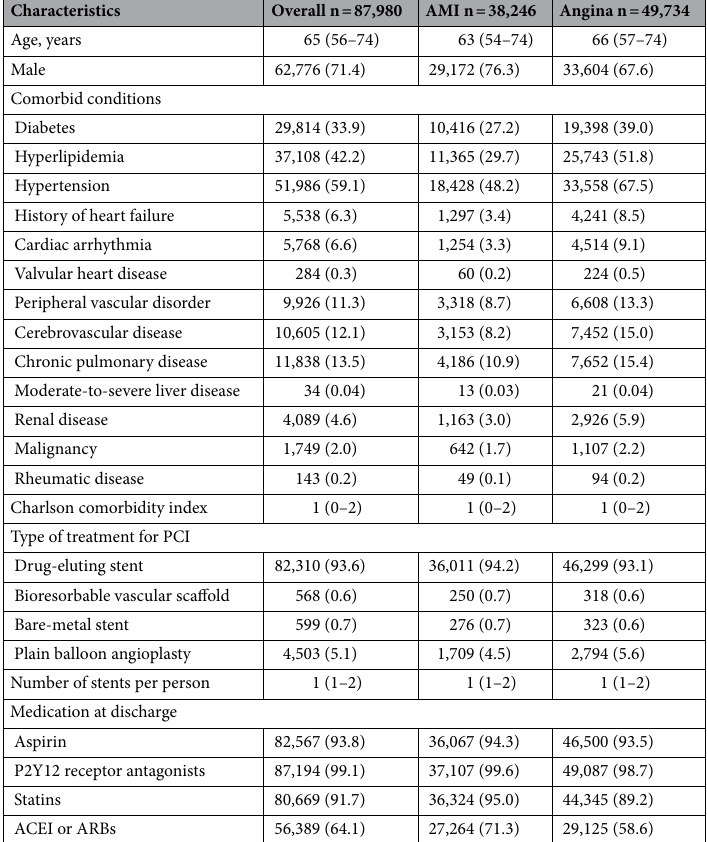
Table 1. Baseline characteristics of the study population. Data are shown as the median (interquartile range) or n (%). ACEI angiotensin-converting enzyme inhibitor, AMI acute myocardial infarction, ARB angiotensin II receptor antagonist, PCI percutaneous coronary